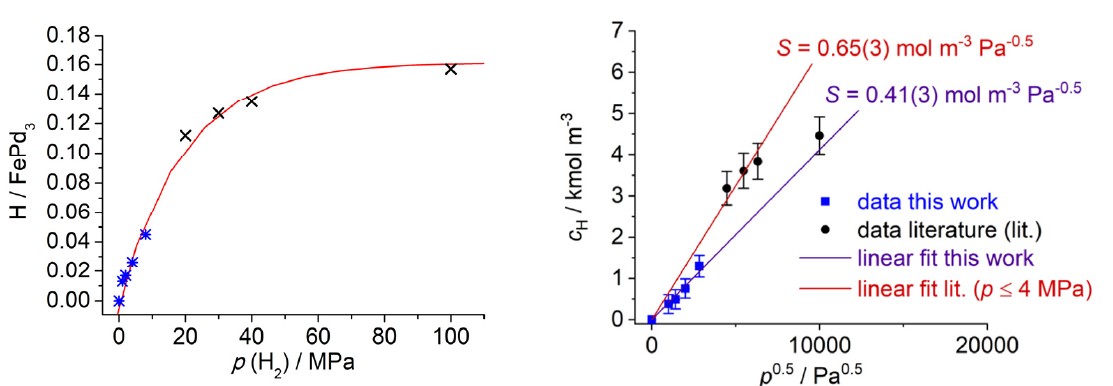
Figure 6. Plot of hydrogen pressure vs. hydrogen content (left) and Sieverts’ law (right, c H = √ S p [36]) of FePd 3 H x . Black symbols mark data from the literature [17], blue symbols from this work. Red line on the left-hand side shows an empirical fitted function ( x = − 0.161(5)e − 0.050(5) p + 0.161(4)) and red and purple lines a linear fit based on Sieverts’